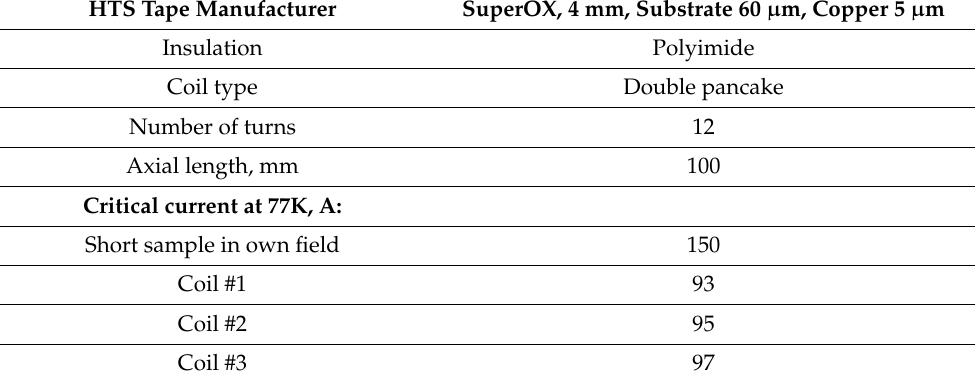
Table 1. Parameters of the HTS tape and coils under